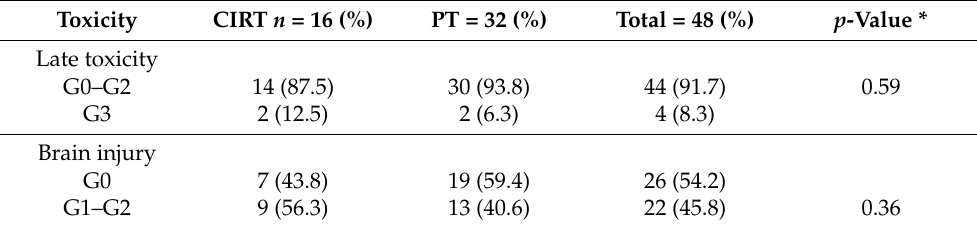
Table 2. Late toxicity and brain